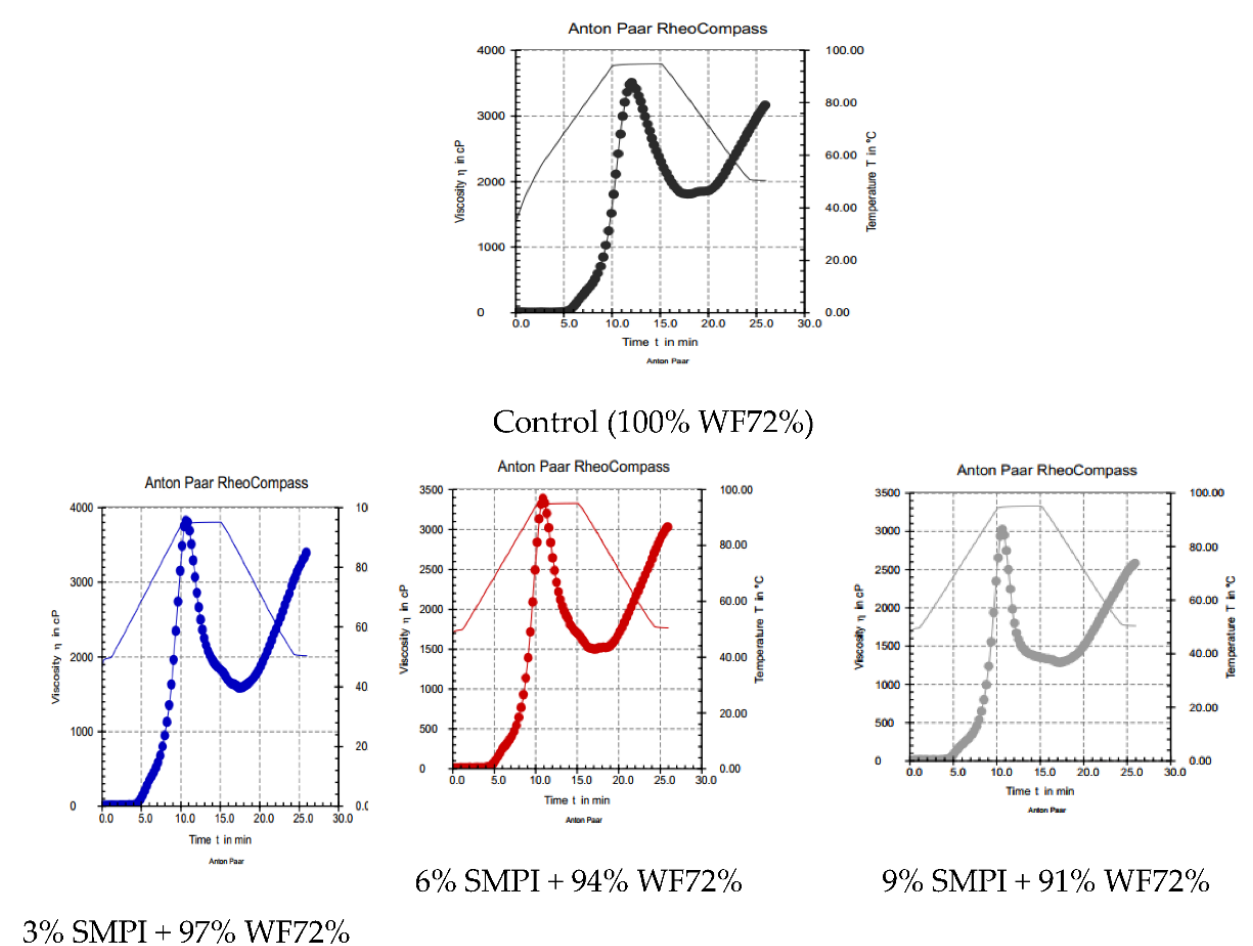
Figure 1. Pasting profile (RVA) of dough WF (72%) supplemented with 3, 6, and 9% SMPI. 3.4. Proximate Composition of Raw Materials (WF, SMPI) and Pasta Table 3. Effect of mixing SMPI with wheat flour on RVA parameters. The proximate compositions of WF, SMPI, pasta, and pasta fortified with different levels of SMPI (3.0, 6.0, and 9.0%) are presented in Table 4. The proximate chemical analysis results indicated that the SMPI sample had 3.47% moisture, 87.12% crude protein, 0.32% fat, 1.87% ash, 2.10% fiber, and 5.15% carbohydrates. The findings of the chemical composition of SMPI are in line with those acquired by Alexandrino et al. [38]. Table 4. Chemical composition of WF, SMPI, and composite pasta (%).